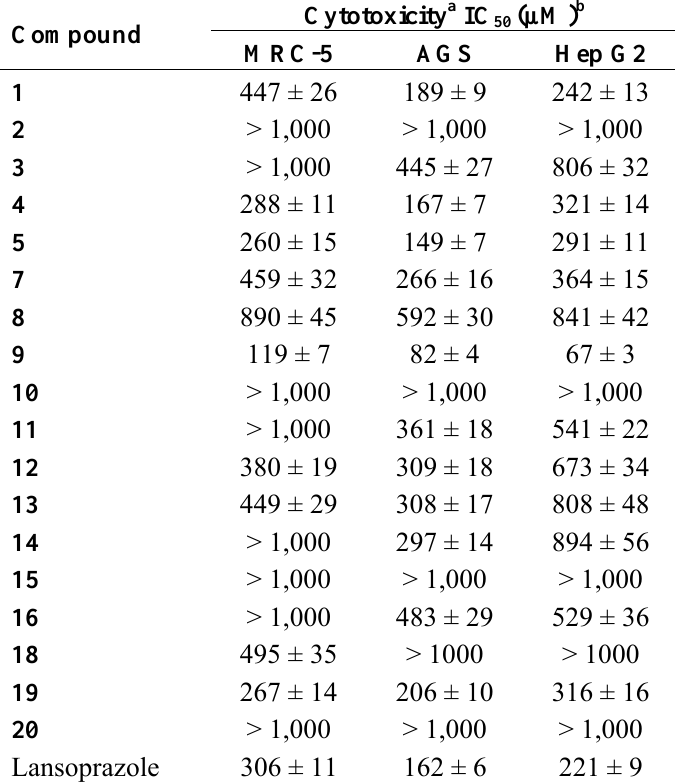
Table 2. Cytotoxicity (IC